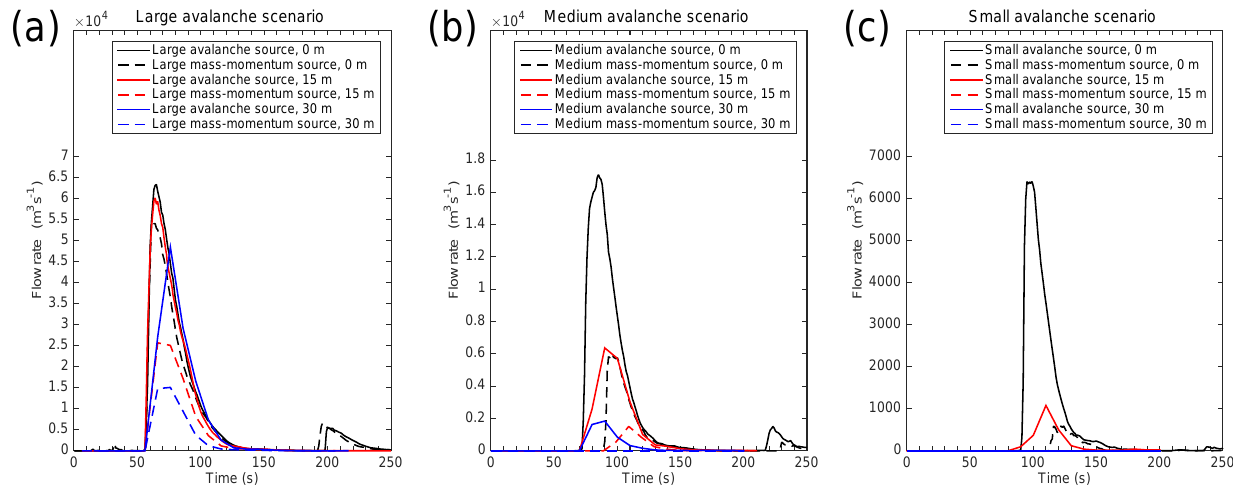
Figure 8. Overtopping hydrographs for lake-lowering scenarios for (a) large avalanche scenario, (b) medium avalanche scenario, and (c) small avalanche scenario. Table 4. Characterization of scenario according to the volume of overtopping discharge. Scenarios labeled as “High discharge” had overtop- ping volumes >20 × 10 3 m 3 . Scenarios labeled as “Medium discharge” had overtopping volumes ≤ 20 × 10 3 m 3 . Scenarios labeled as “No discharge” did not result in any